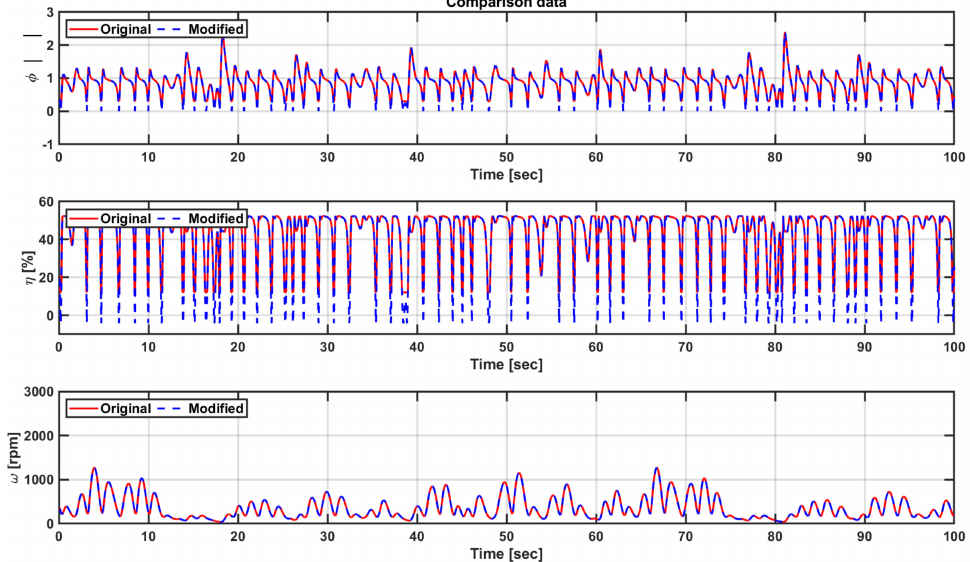
Figure 31. Simulation comparison results of turbine system about flow coe ffi cient( | Φ | ), e ffi ciency and rotation speed according to flow coe ffi cient range change under irregular wave ( v t = 0~42 m / s and Tp = 4.75 s) input